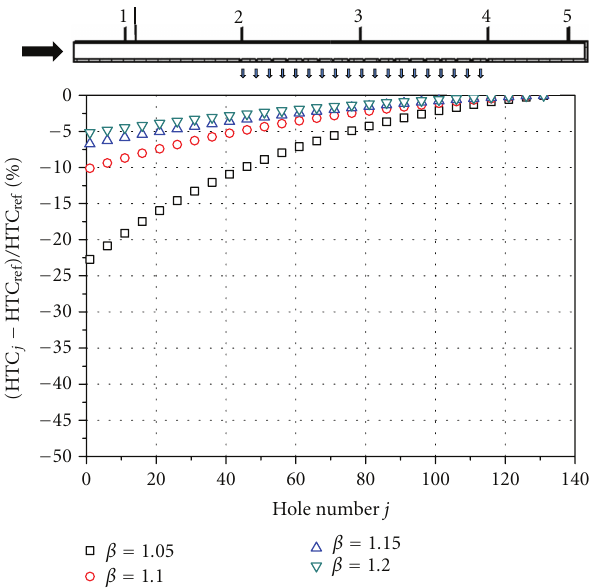
Figure 14: Mean heat transfer coe ffi cient distribution varying the β parameter.